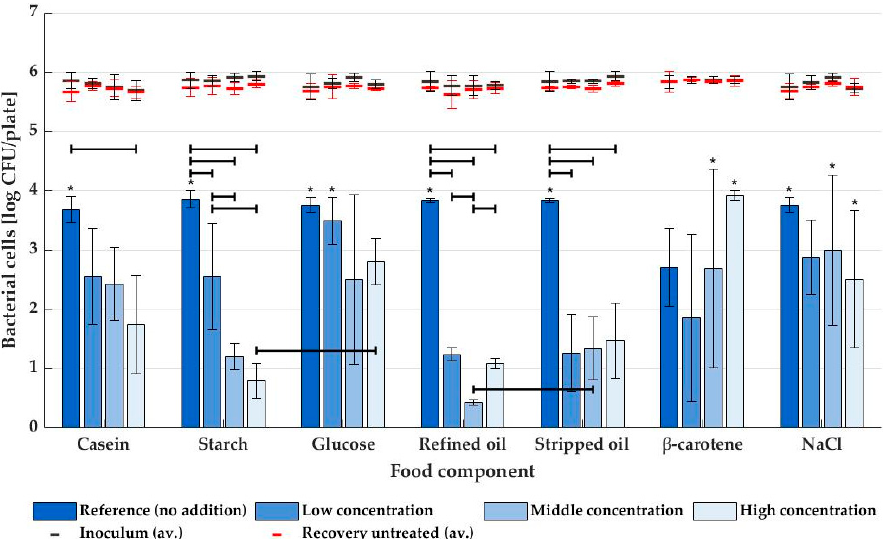
Figure 3. Average NTP inactivation levels (and standard deviations) of STEC on agar media sup- plemented with various food matrix components ( n = 3), with plasma generated from dry air. An asterisk (*) indicates that inactivation reached LOD for at least one repeat. All components were tested at low, middle, and high concentrations (see Table 1) and compared against a reference sample without addition. The average inoculum and number of cells recovered from untreated samples are given as black and red lines, respectively. Significant differences between inactivation levels are indicated with black horizontal lines.